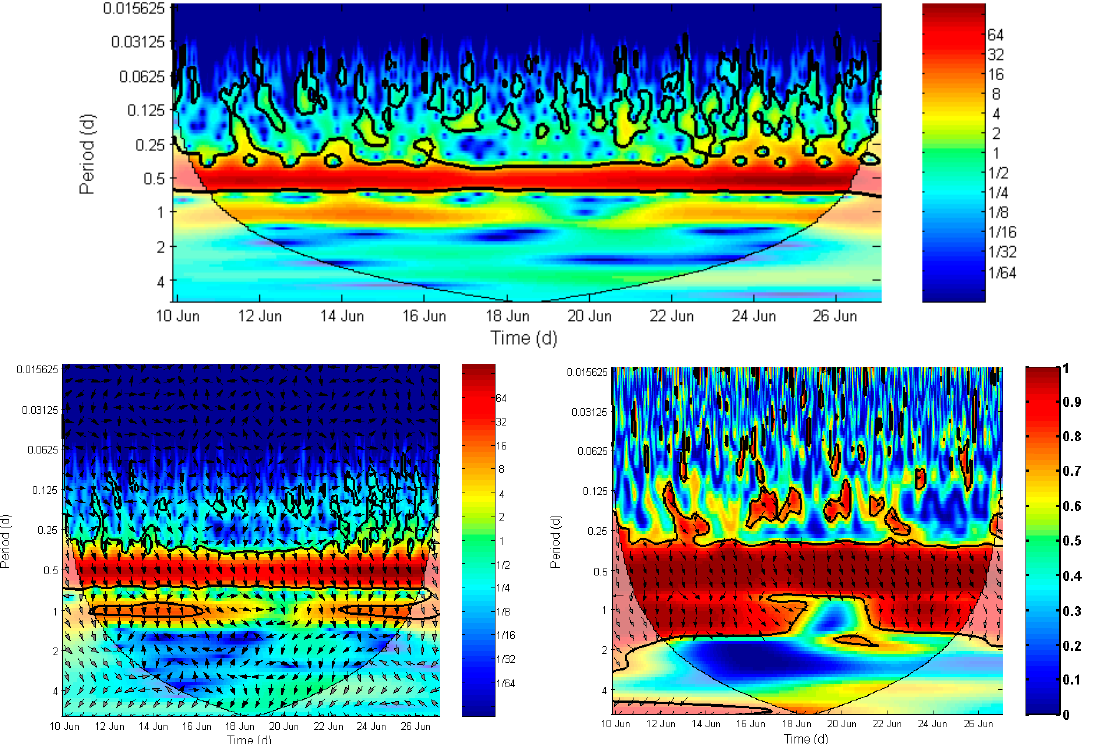
Figure 7. Wavelet analyses in eastern branch: (top) continuous wavelet transformation; (bottom left) cross-wavelet transform; (bottom right) wavelet coherence. The black contours represent the 0.95 confidence level against red noise, and the cone of influence (COI) where edge effects might distort the picture is shown as a lighter shade. The relative phase relationship is shown as arrows (with in-phase pointing right, anti-phase pointing left, and the first time series leading the second one by 90 ° pointing down). The wavelet power is log (cid:2870) ( A 2 / v ), where A is the wavelet amplitude and v is the variance of the original tidal signals. The y -axis in the CWT and XWT is on a log (cid:2870) scale.